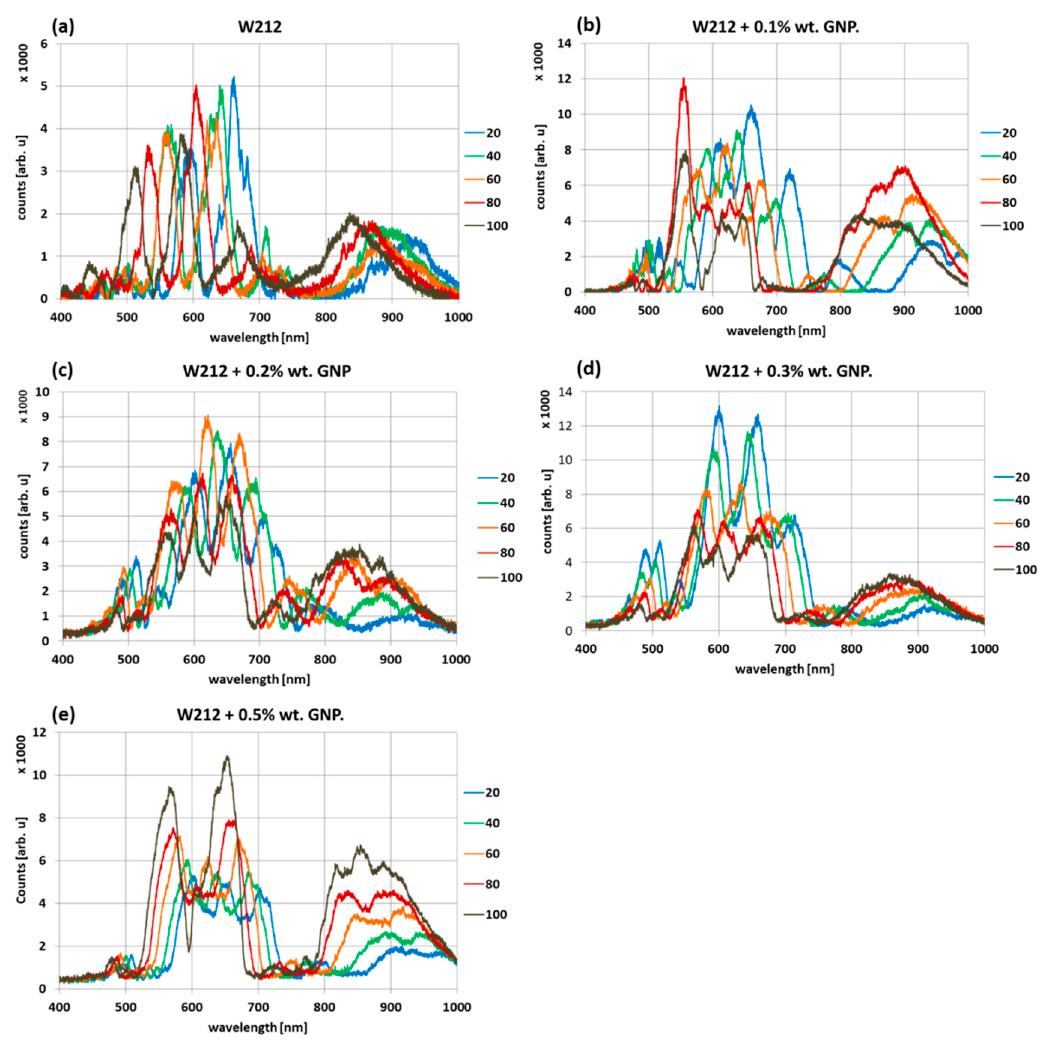
Figure 5. Spectra for photonic liquid crystal fibers (PLCFs) infiltrated with ( a ) undoped W212 FLC and FLCs doped with GNPs at concentrations of ( b ) 0.1% wt., ( c ) 0.2% wt., ( d ) 0.3% wt., ( e ) 0.5% wt.